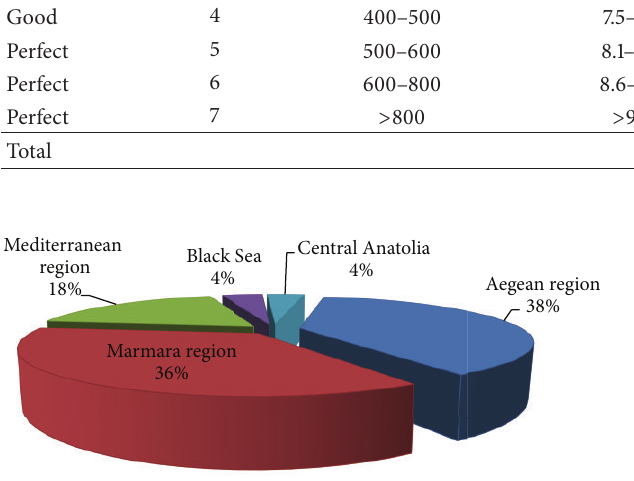
Figure 7: Distribution of wind energy power stations according to the regions in